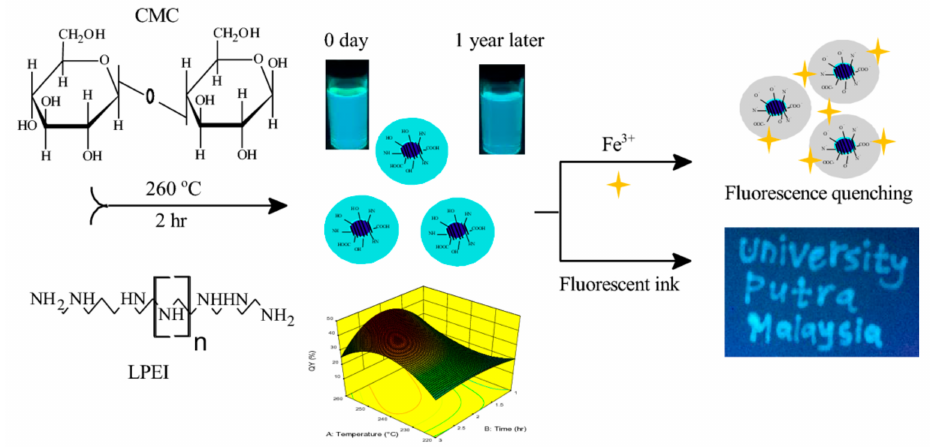
Figure 3. Schematic illustration of the synthesis of N-CQDs using CMC and LPEI as precursors; their application in Fe 3+ sensing and as fluorescent ink. Reprinted from Ref.